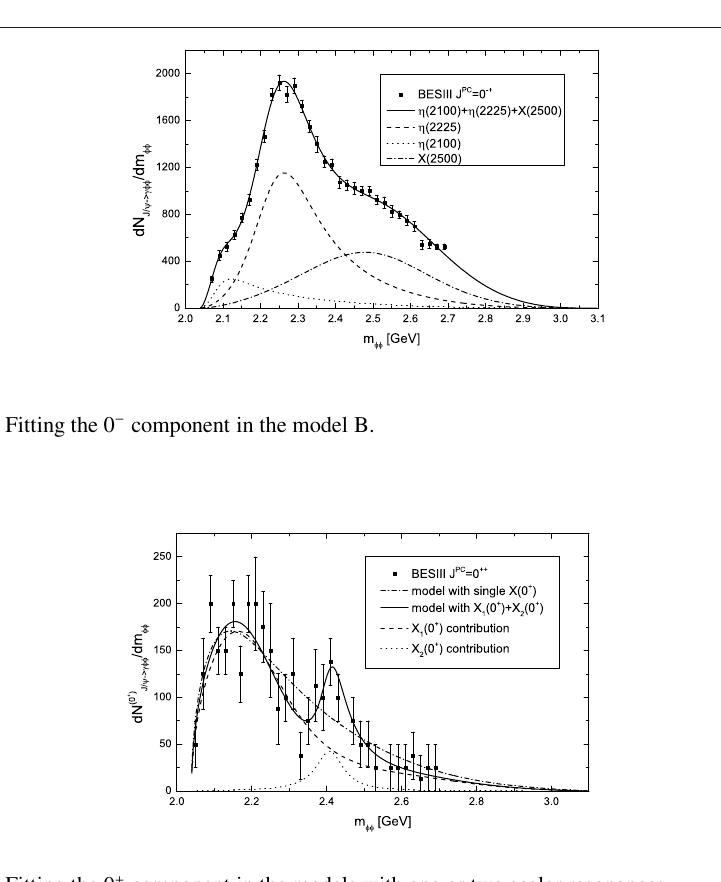
Figure 3. Fitting the 0 + component in the models with one or two scalar